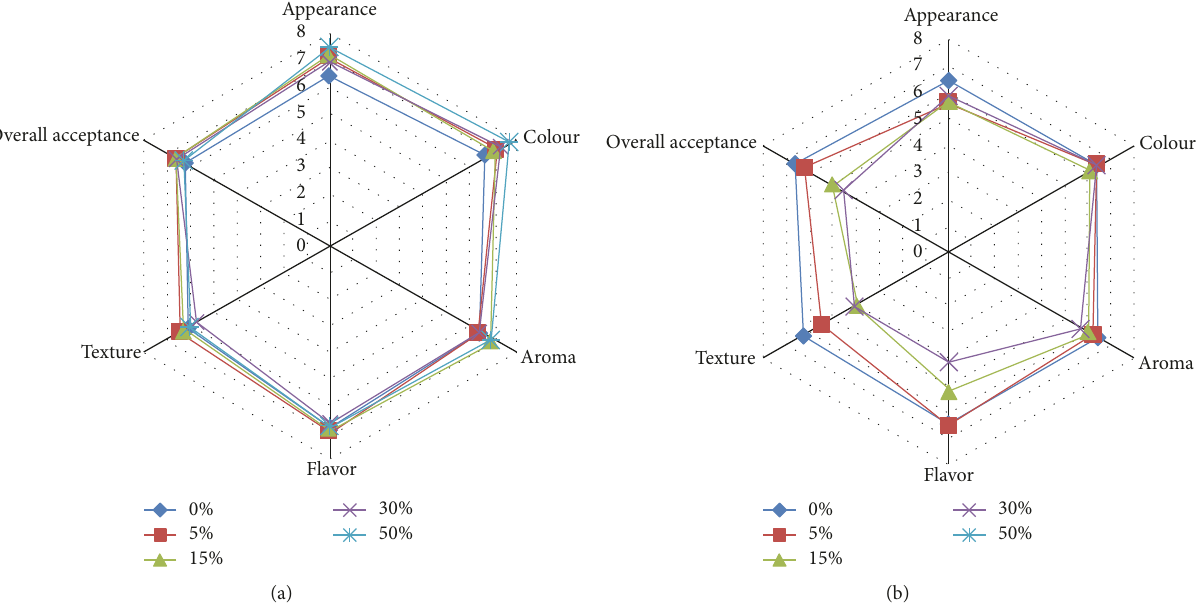
Figure 2: Graphical representation for organoleptic properties: age range of 27 to 59 years and (b) age range of 16 to 24